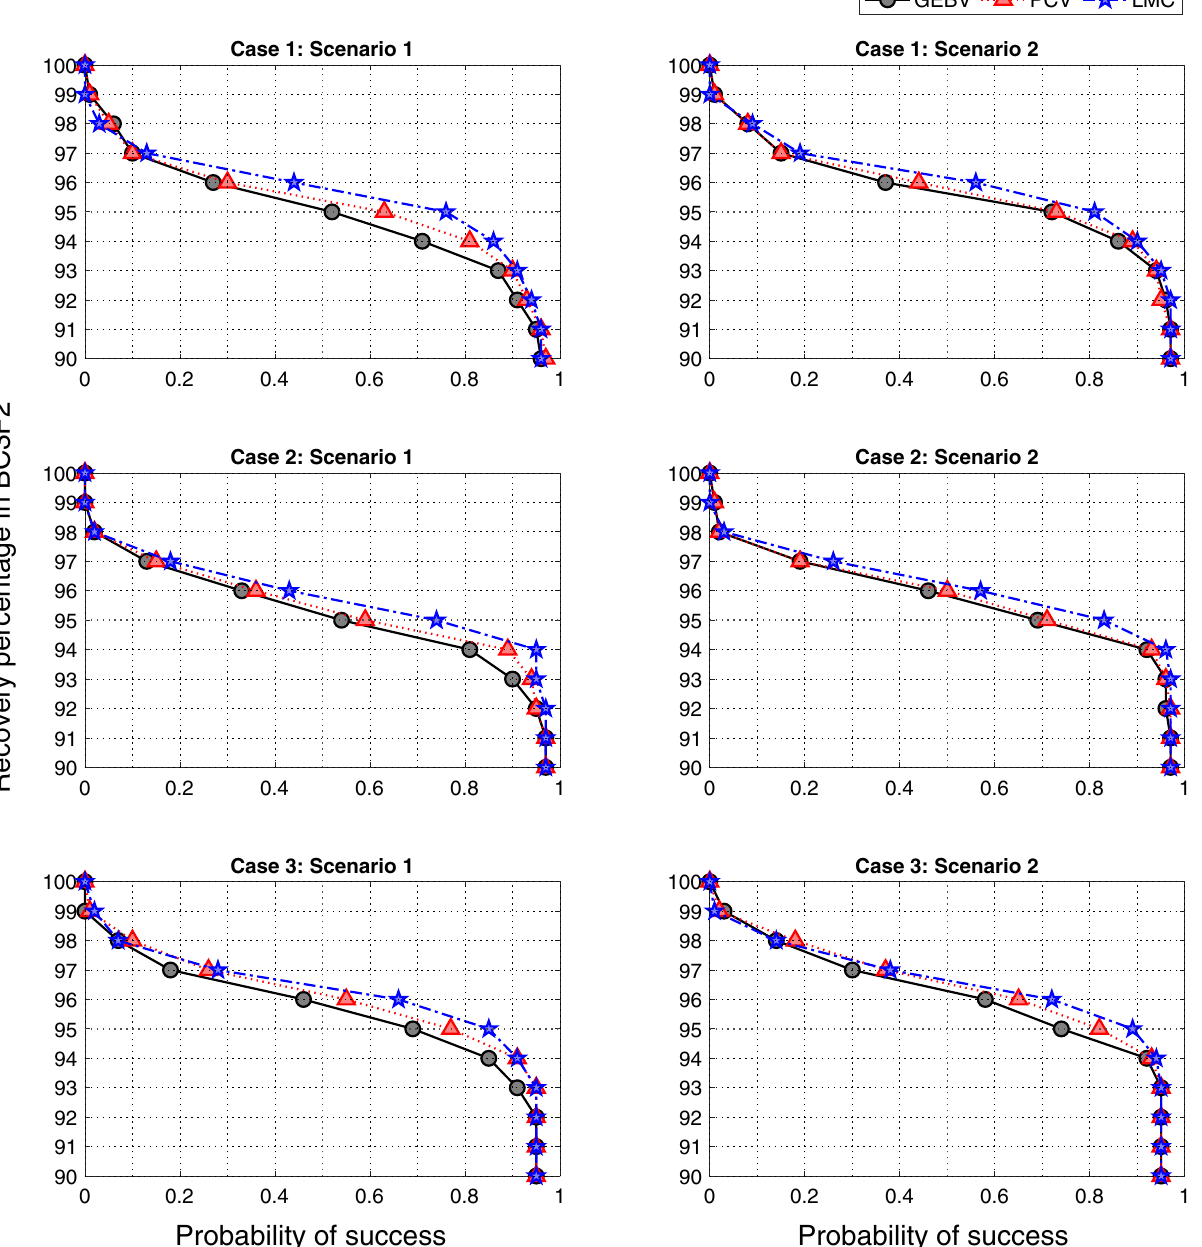
Figure 7. Probability of success in BC3F2 for three different selection approaches considering 3 cases of initial genetic similarity and 2 scenarios of resource allocation for 100 simulation replicates. The maximum recovery percentage of positive individuals in BC3F2 is first identified and then probability of success has been defined as the proportion of simulations that have achieved a certain